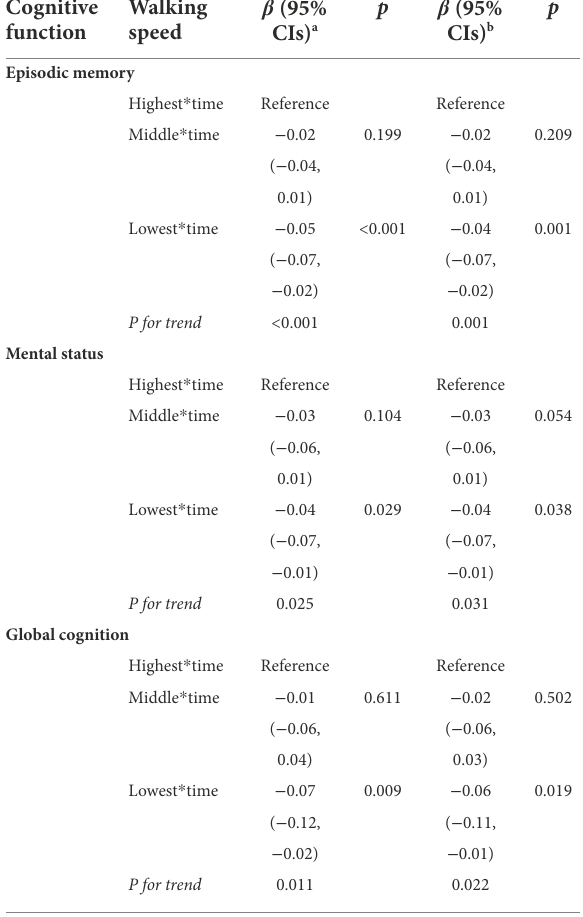
TABLE 3 The association between FGCRS and change in cognitive function over time in the CHARLS. Cognitive